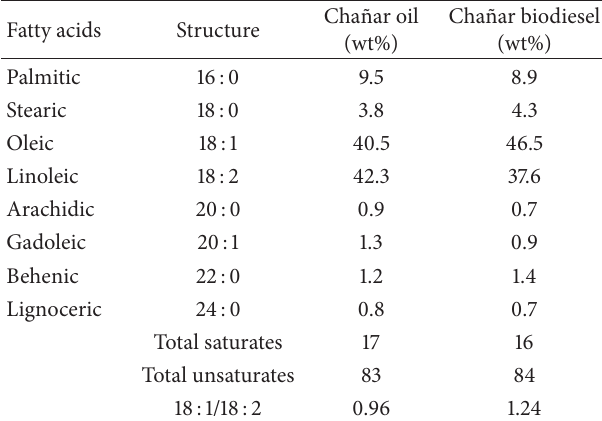
Table 2: Detailed profile of the fatty acids of cha˜nar oil and biodiesel obtained from transesterification reaction with methanol.